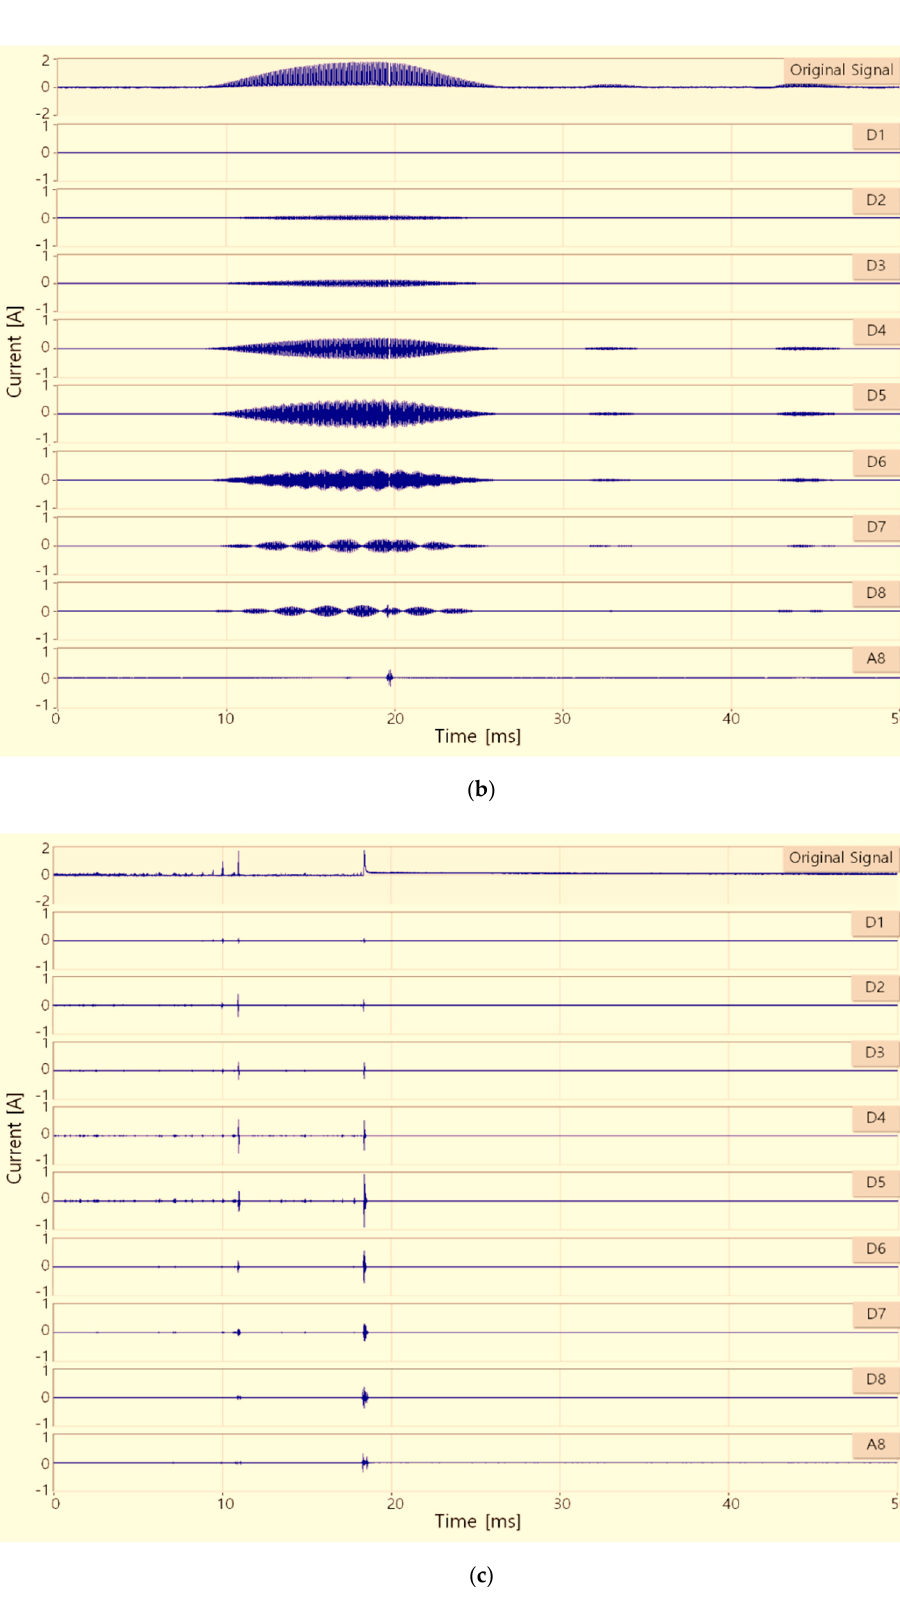
Figure 10. Decomposition of the current signal. ( a ) normal status; ( b ) arc status (cord-cord); ( c ) arc status (carbon-copper).